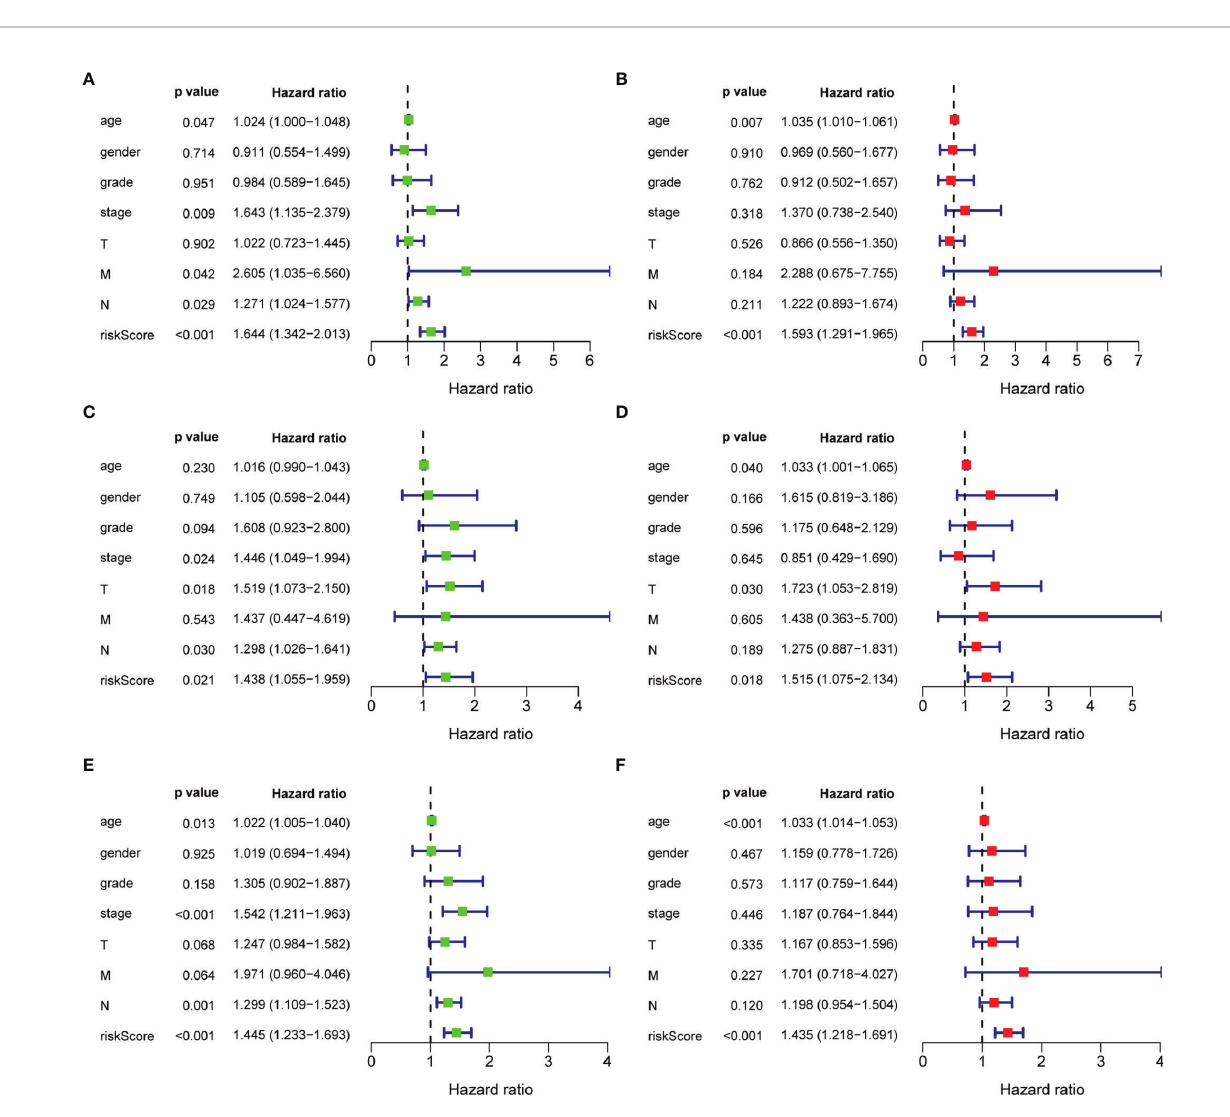
FIGURE 6 | Univariate and multivariate analysis of overall survival of patients. (A, C, E) Univariate analysis; (B, D, F) Multivariate